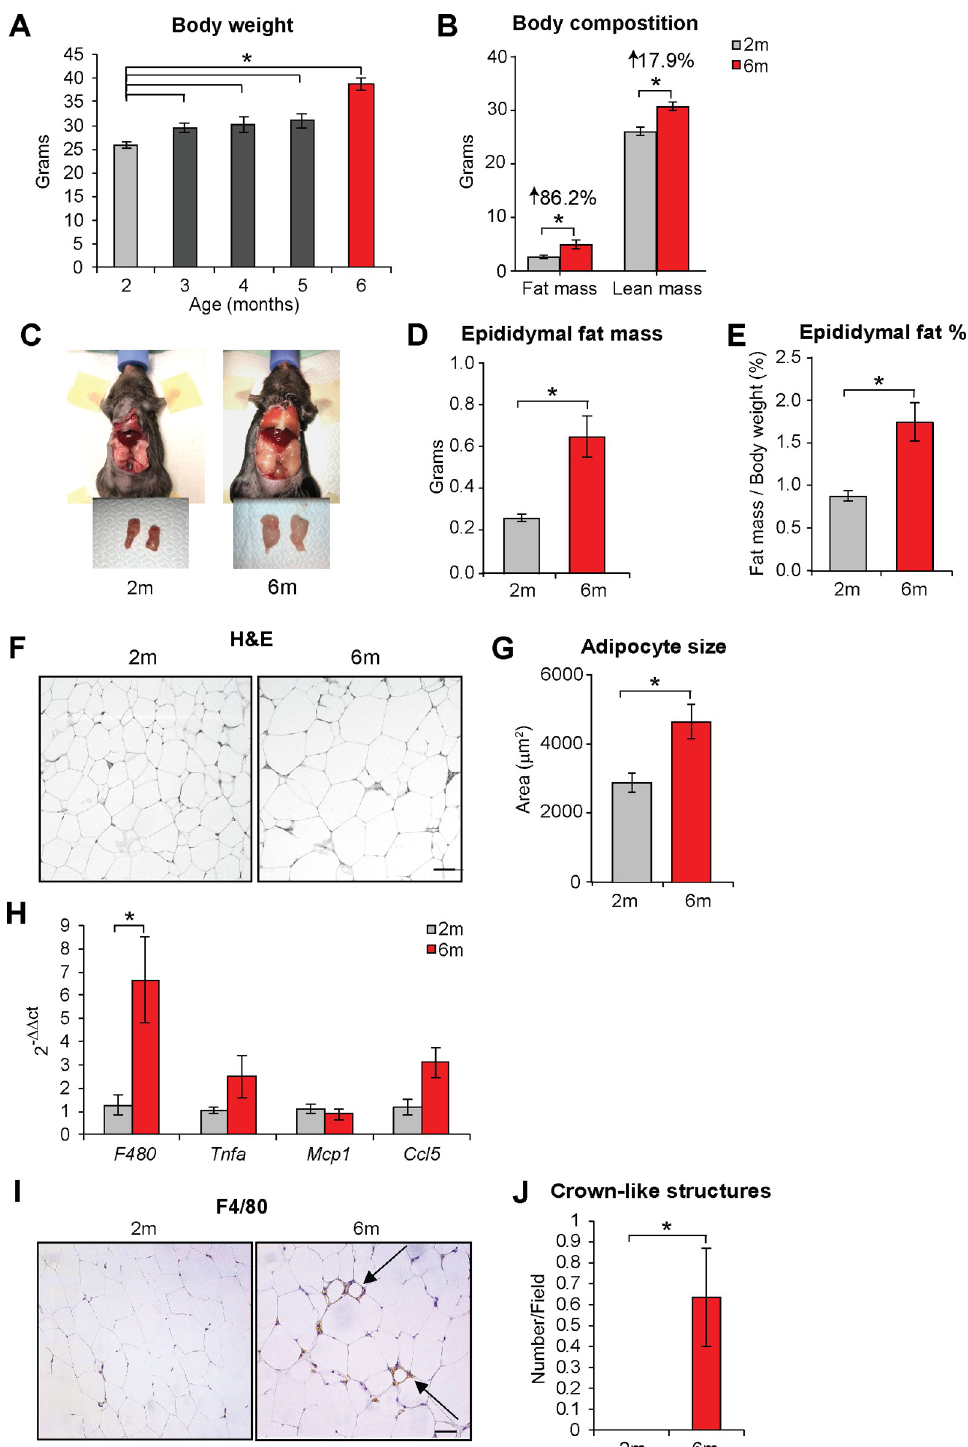
Fig 1. Increased body weight during early adulthood is accompanied by hypertrophy and inflammation of visceral adipose tissue. (A) Body weight of mice in the first 6 months of age when fed a normocaloric chow diet. (B) Whole body composition (fat and fat free mass) measured by nuclear magnetic resonance imaging in 2 and 6 months old mice. Numbers above the bars represent the percentage of weight increase at 6 months of age. (C) Representative macrograph of epididymal fat pads in 2 and 6 months old mice. (D) Quantification of epididymal fat mass, expressed in grams, in